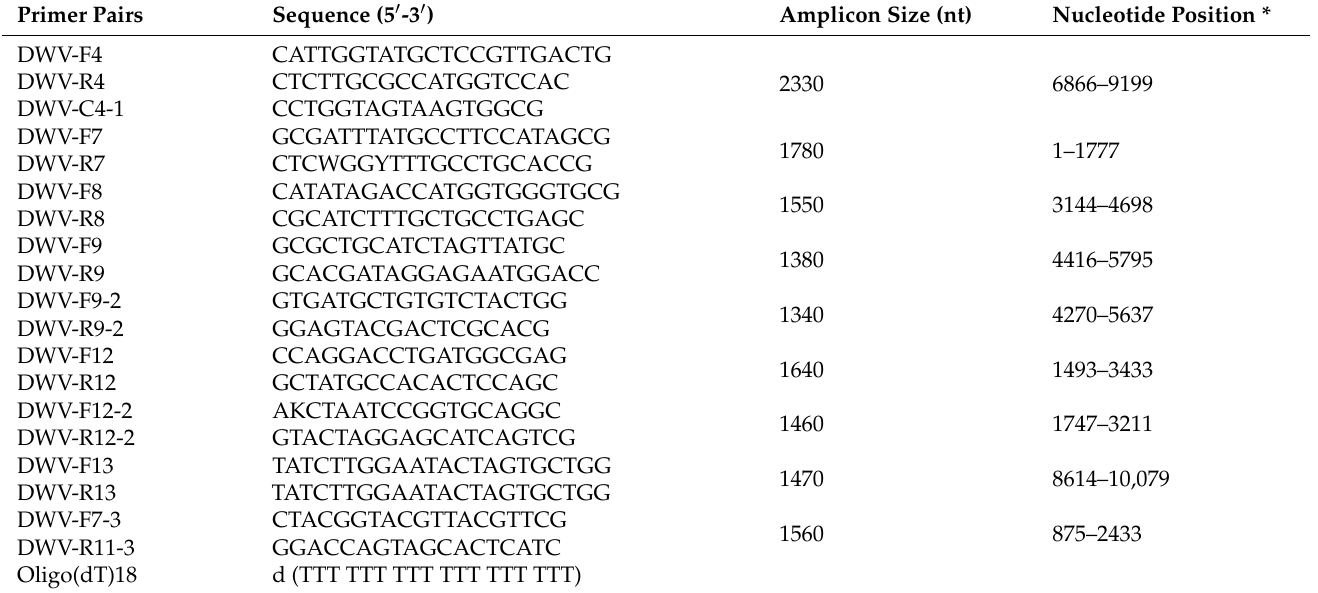
Table 1. The primers designed for overlapping sequences to ensure the complete polyprotein sequencing of the selected DWV